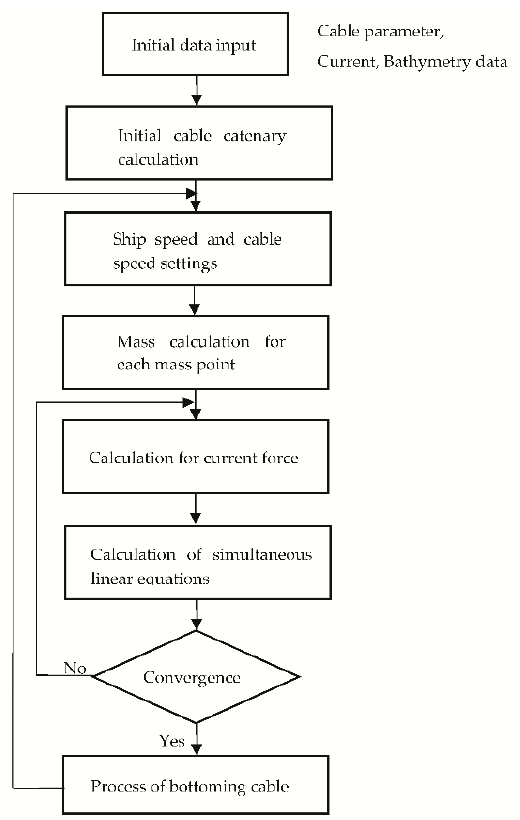
Figure 10. Flowchart of simulation of cable behavior in the water.